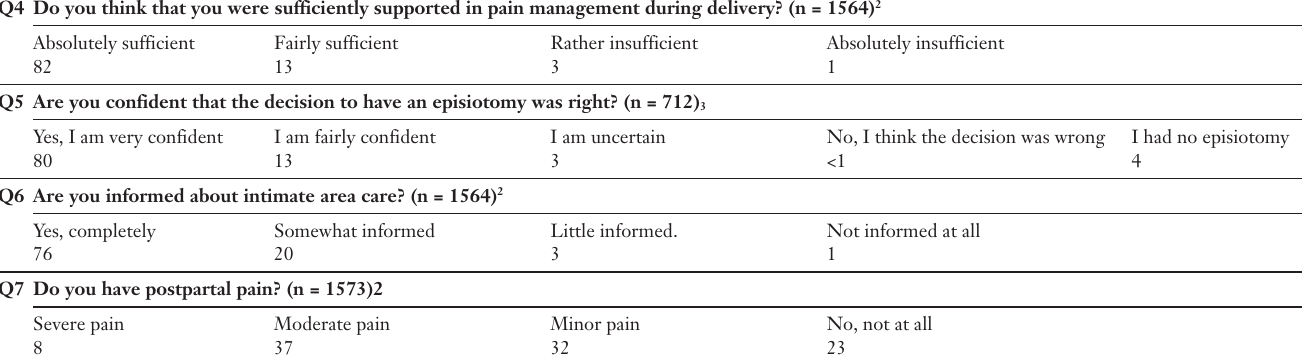
Summary of responses to individual questions related to vaginal delivery presented in the questionnaire. Values are percentages of patients to whom the question applied and who answered the question. Questions related to vaginal delivery only (n = 1620)